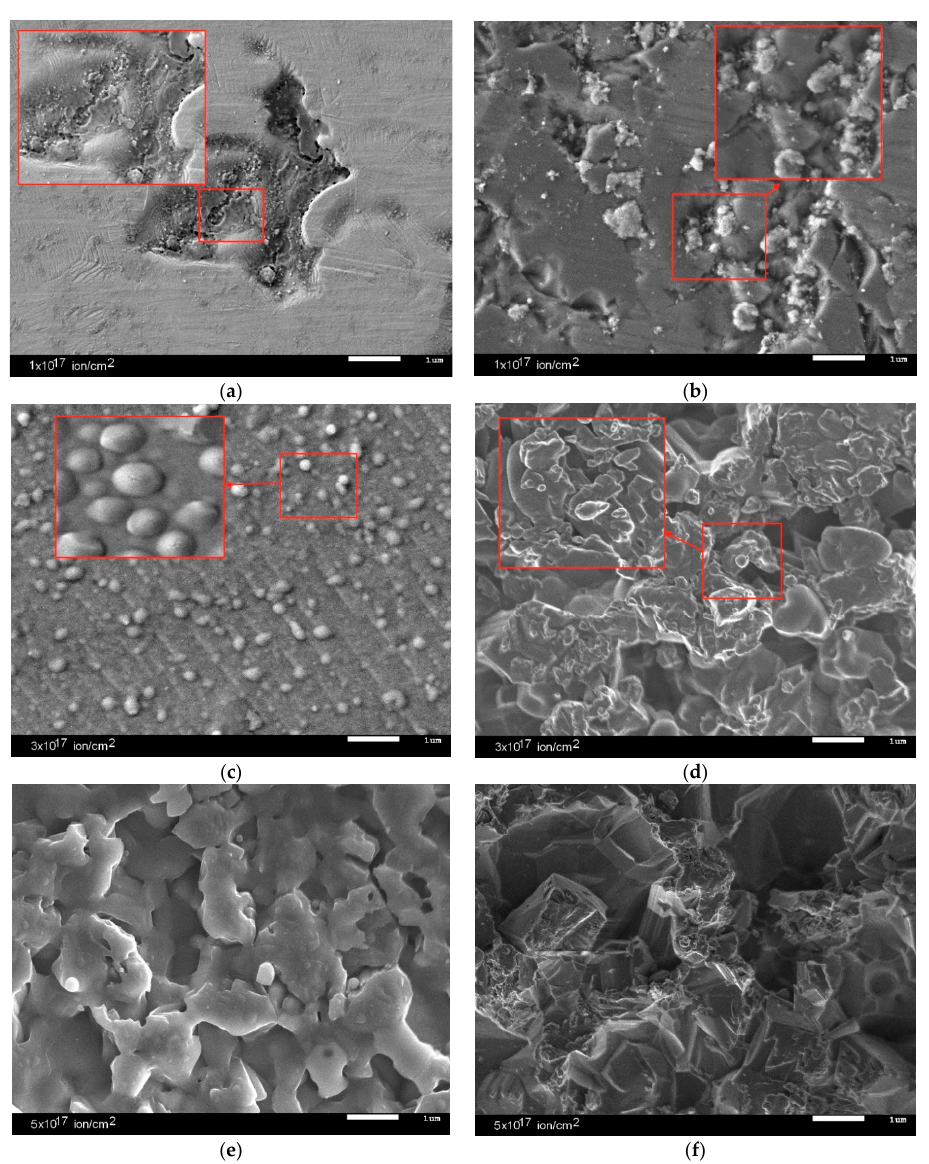
Figure 4. SEM images of samples surface after irradiation. ( a ) 10 17 ion/cm 2 , 300 K; ( b ) 3 x 10 17 ion/cm 2 , 300 K; ( c ) 5 x 10 17 ion/cm 2 , 300 K; ( d ) 10 17 ion/cm 2 , 1000 K; ( e ) 3 x 10 17 ion/cm 2 , 1000 K; ( f ) 5 x 10 17 ion/cm 2 , 1000 300 K; ( c ) 5 × 10 17 ion / cm 2 , 300 K; ( d ) 10 17 ion / cm 2 , 1000 K; ( e ) 3 × 10 17 ion / cm 2 , 1000 K; ( f ) 5 × 10 17 K. ion / cm 2 , 1000